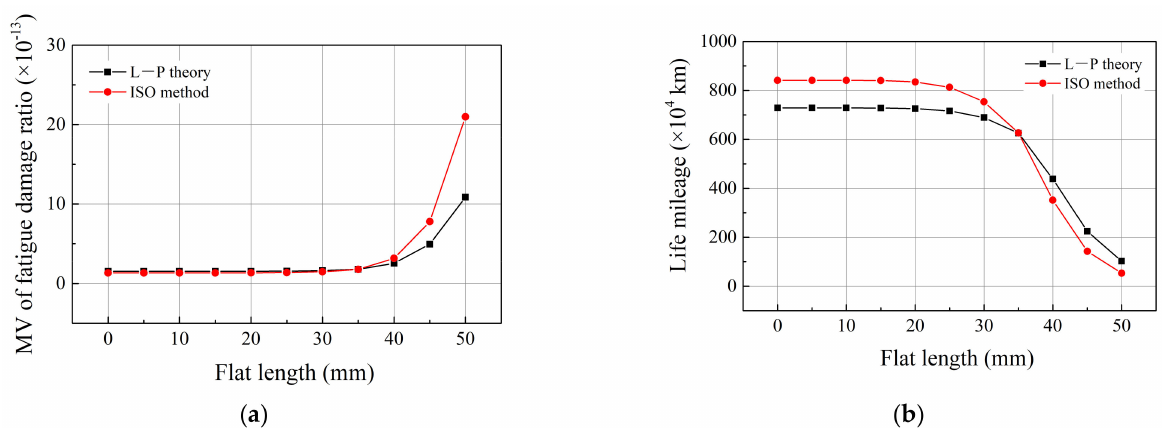
Figure 12. Variations of life mileage of motor bearing versus the flat length: ( a ) RMS of instantaneous fatigue damage and ( b ) life mileage of the motor